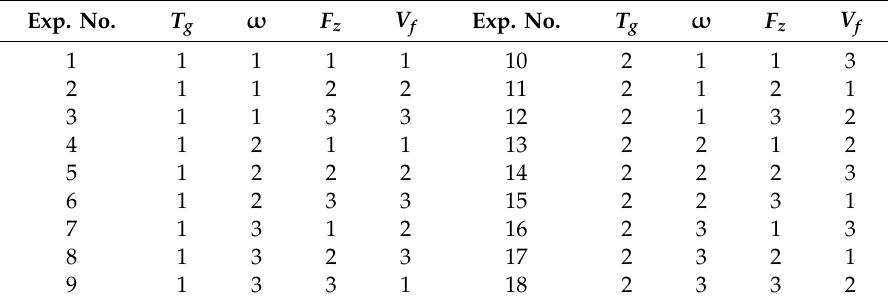
Table 2. Orthogonal array L 18 ( 2 1 × 3 3 )